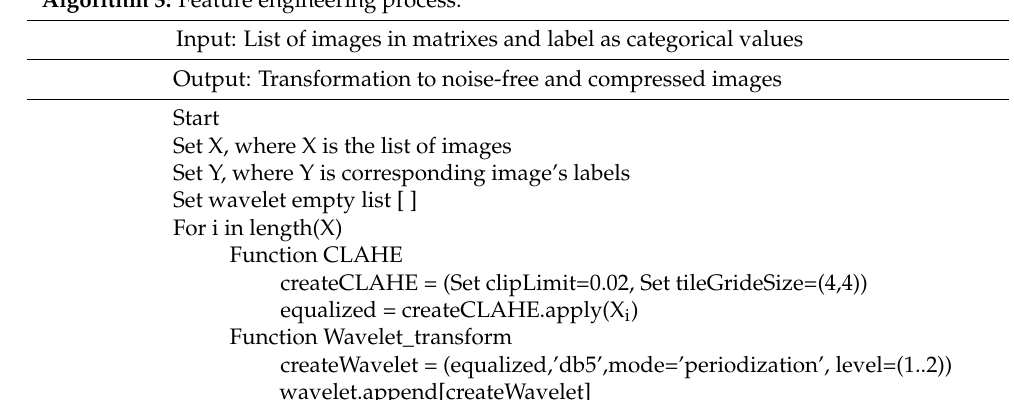
Algorithm 3: Feature engineering process.